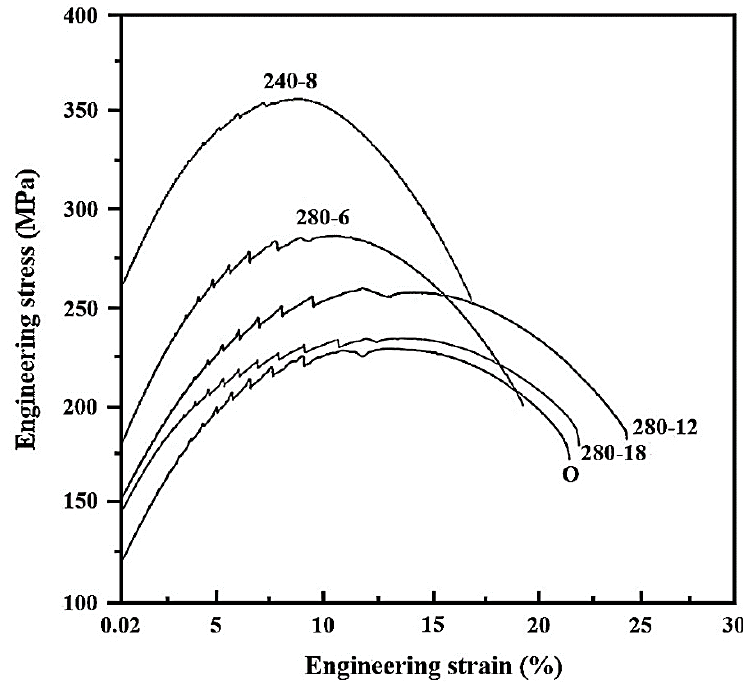
Figure 9. Stress-strain flow curve of 7075 Al alloy extruded rod after various PPHTs.